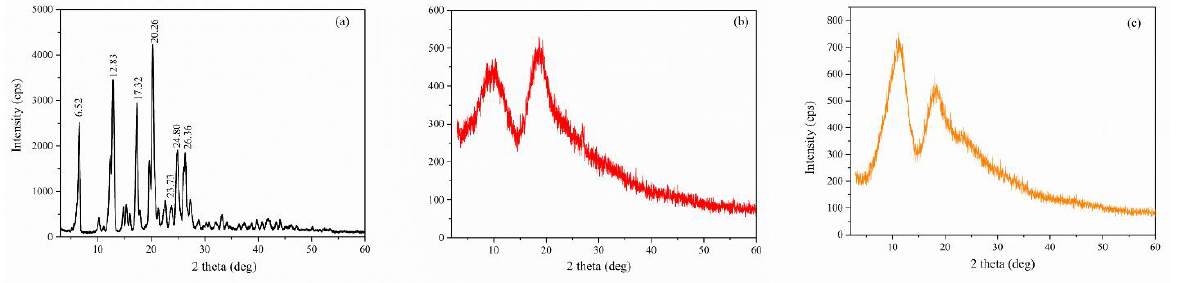
Figure 8. XRD pattern of ( a ) Nim (mod I); ( b ) HP- β -CD; ( c ) Me- β